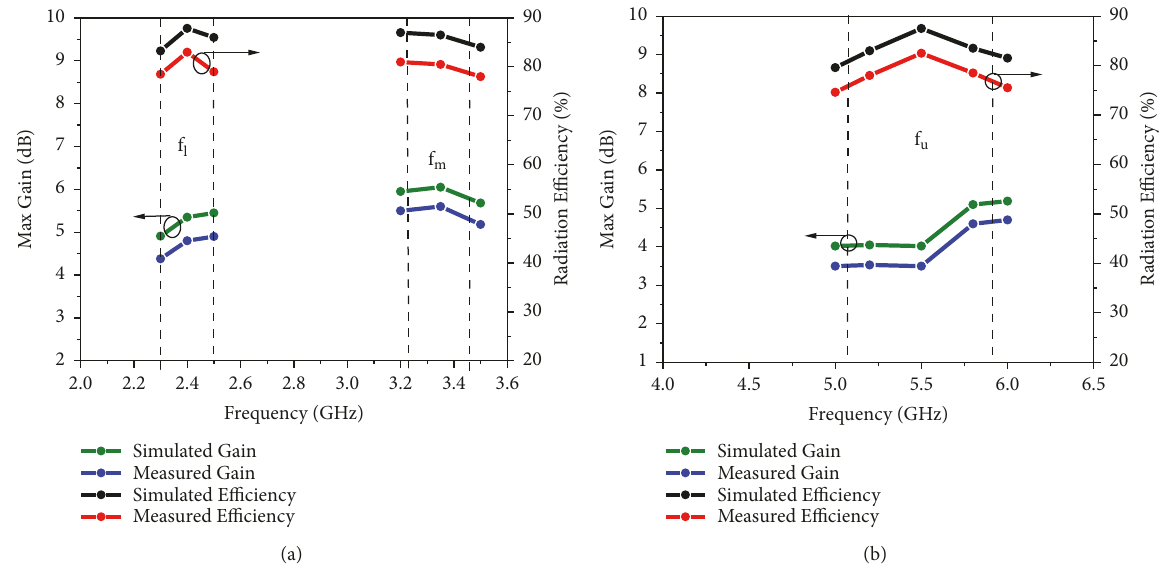
Figure 14: Simulated and measured gain and efficiency of proposed MIMO antenna.